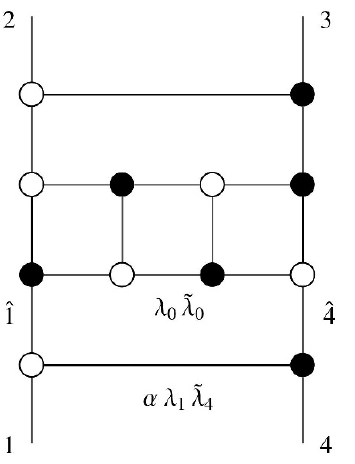
Figure 16 . On-shell diagram for 1-loop four-point amplitude in N =4